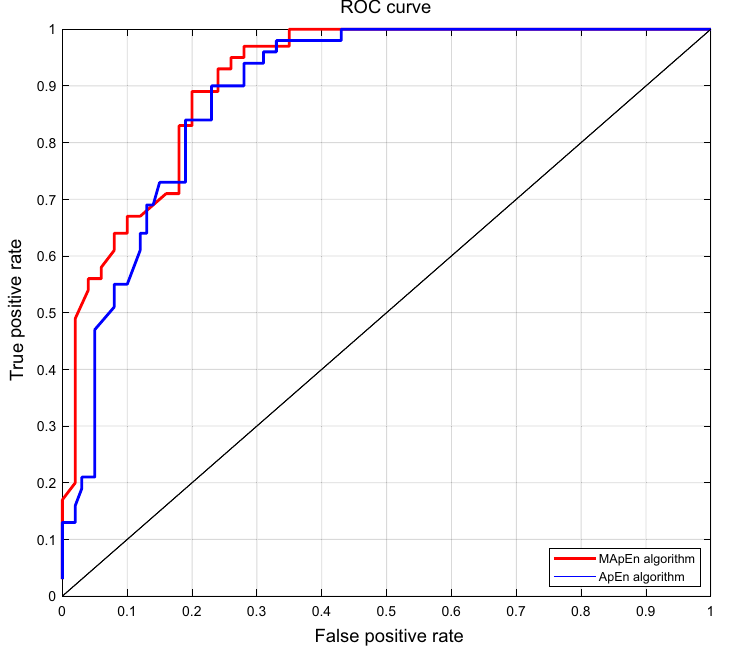
Figure 8. The ROC curves of bi-classification models.